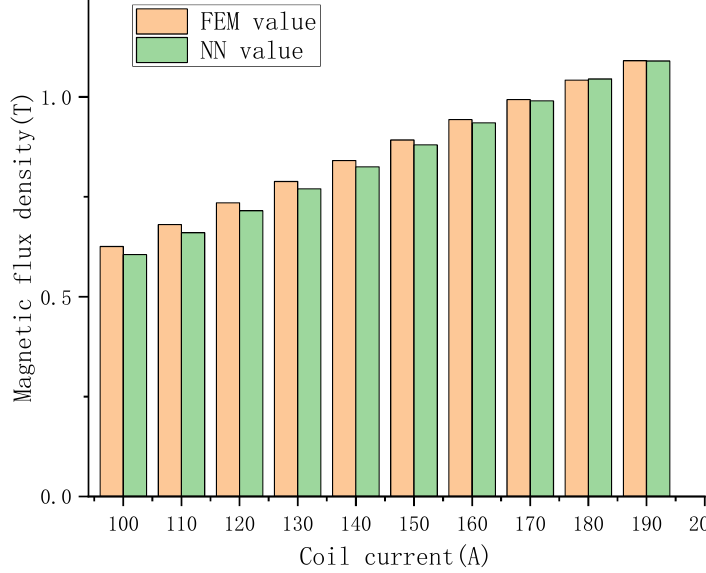
Figure 13. Comparison of magnetic flux density calculations for linear materials. When the magnetization model is the B - H curve, the application example is shown in Figure 14.